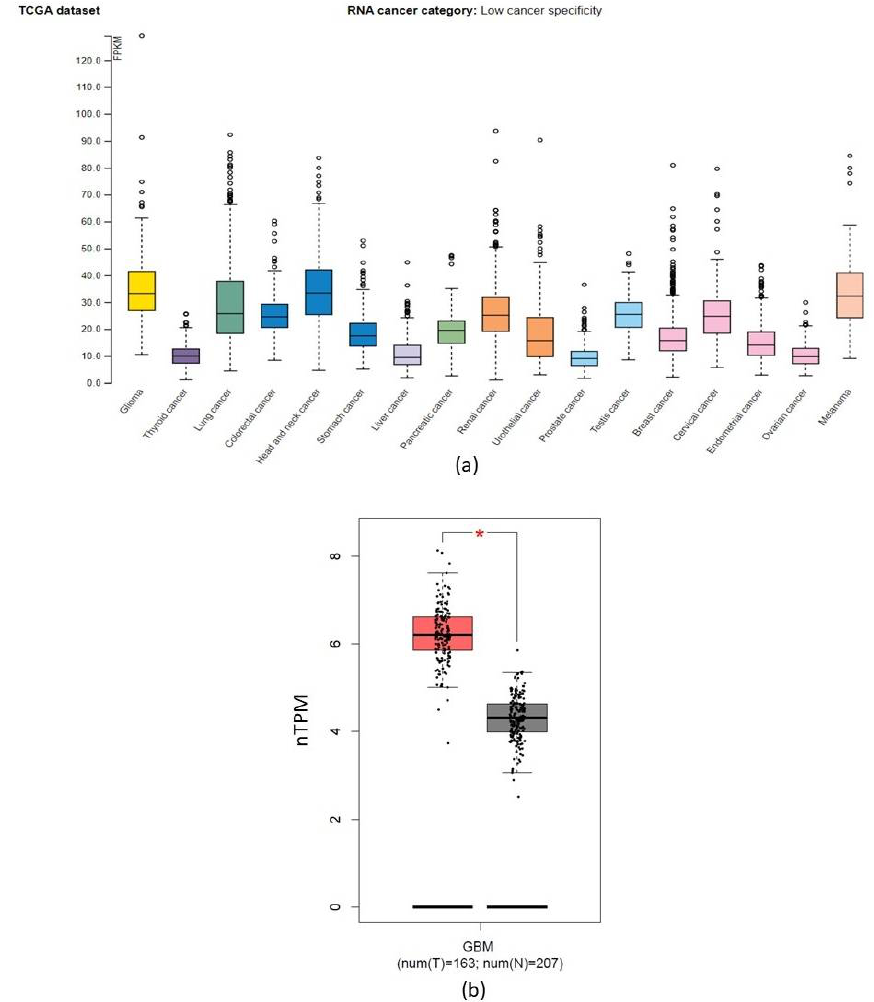
Figure 3. Expression of CORO1C in various cancerous tissues. ( a ) CORO1C expression across 17 cancer types revealed that the gene was highly expressed in head and neck cancer, gliomas, and melanomas. ( b ) CORO1C was significantly upregulated in GBM tumour samples (red) in comparison to normal brain tissue (grey) (One way ANOVA, * p < 0.01).